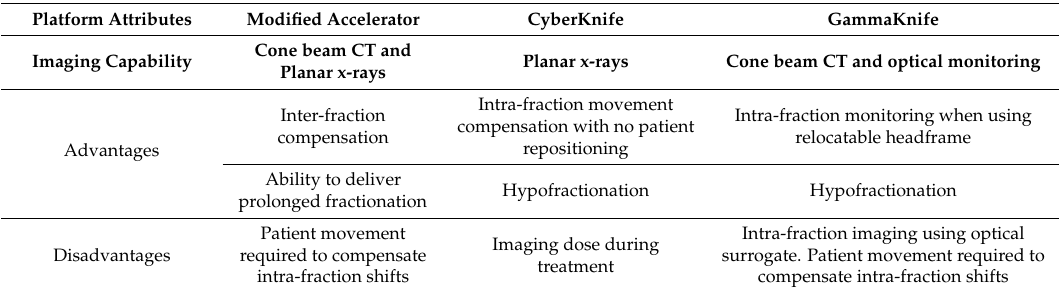
Table 3. Technical differences between radiosurgery platforms.